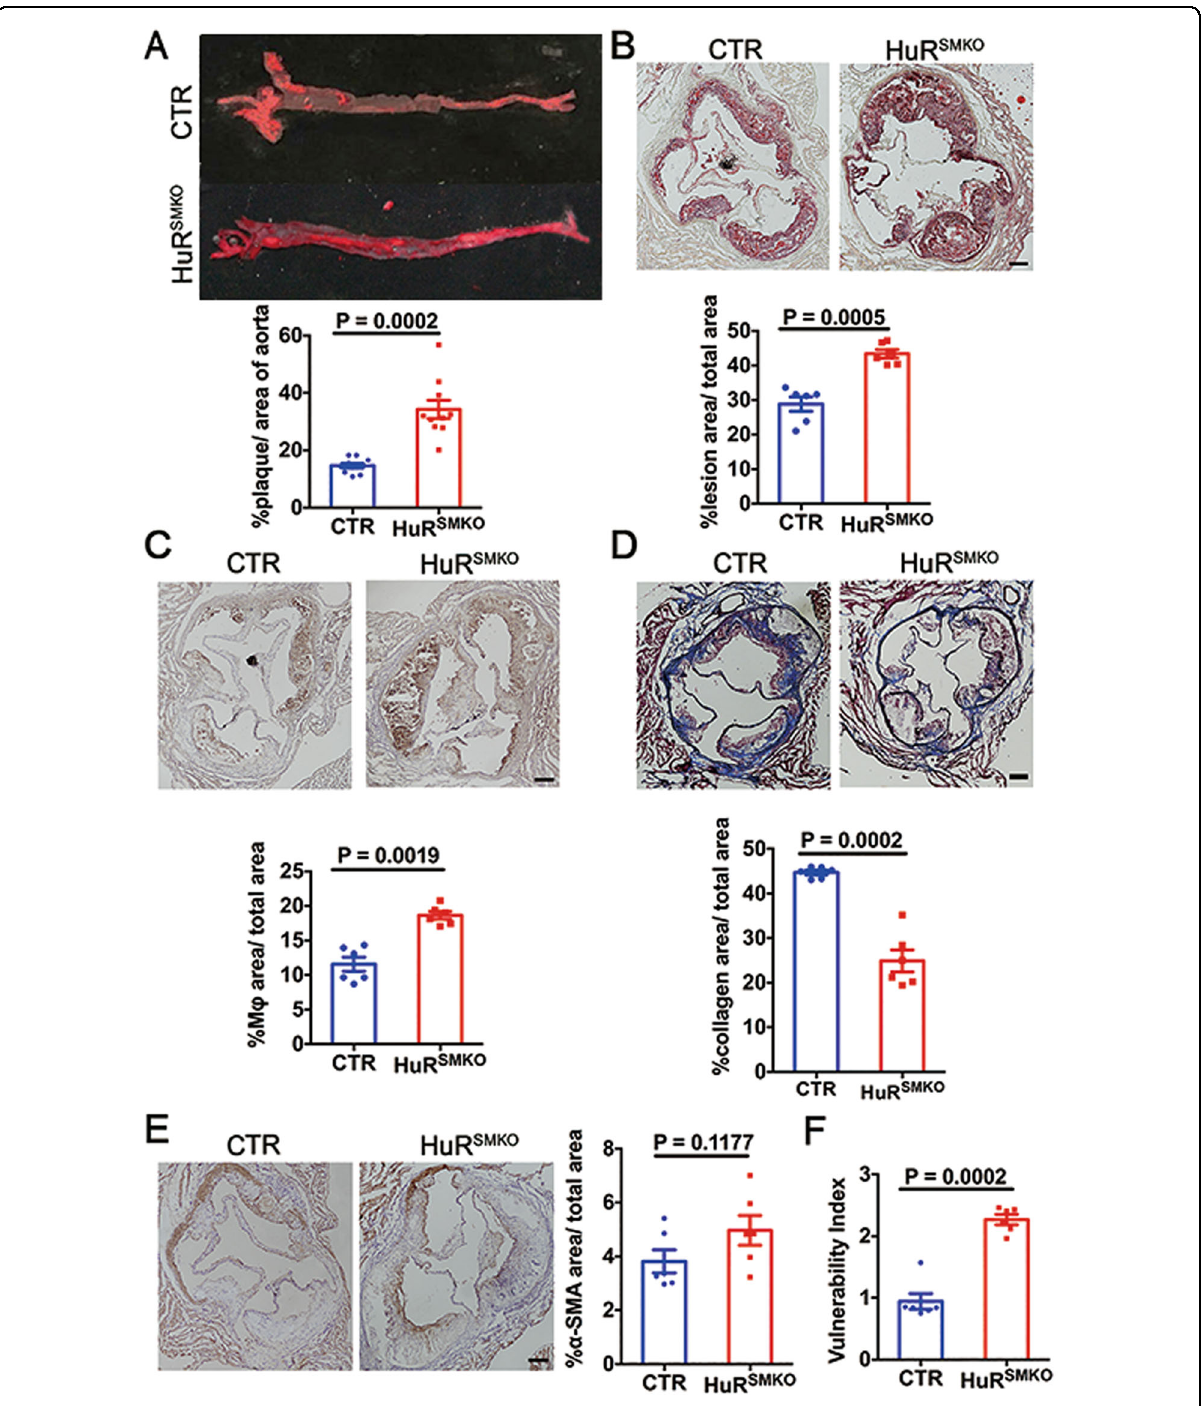
Fig. 2 HuR deletion in smooth muscle cells exacerbated atherosclerosis. CTR and HuR SMKO mice were injected with rAAV/D377Y-mPCSK9 and fed a Paigen diet for 12 weeks. A Oil-red O staining in aortas ( n = 10). B Oil-red O staining in aortic roots ( n = 6). Scale bar = 200 μ m. c Immunohistochemical staining of MOMA-2 in aortic roots ( n = 6). Scale bar = 200 μ m. D Masson staining in aortic roots ( n = 6). Scale bar = 200 μ m. E Immunohistochemical staining of α -SMA ( n = 6). Scale bar = 200 μ m. F Vulnerable index of atherosclerotic plaques ( n =